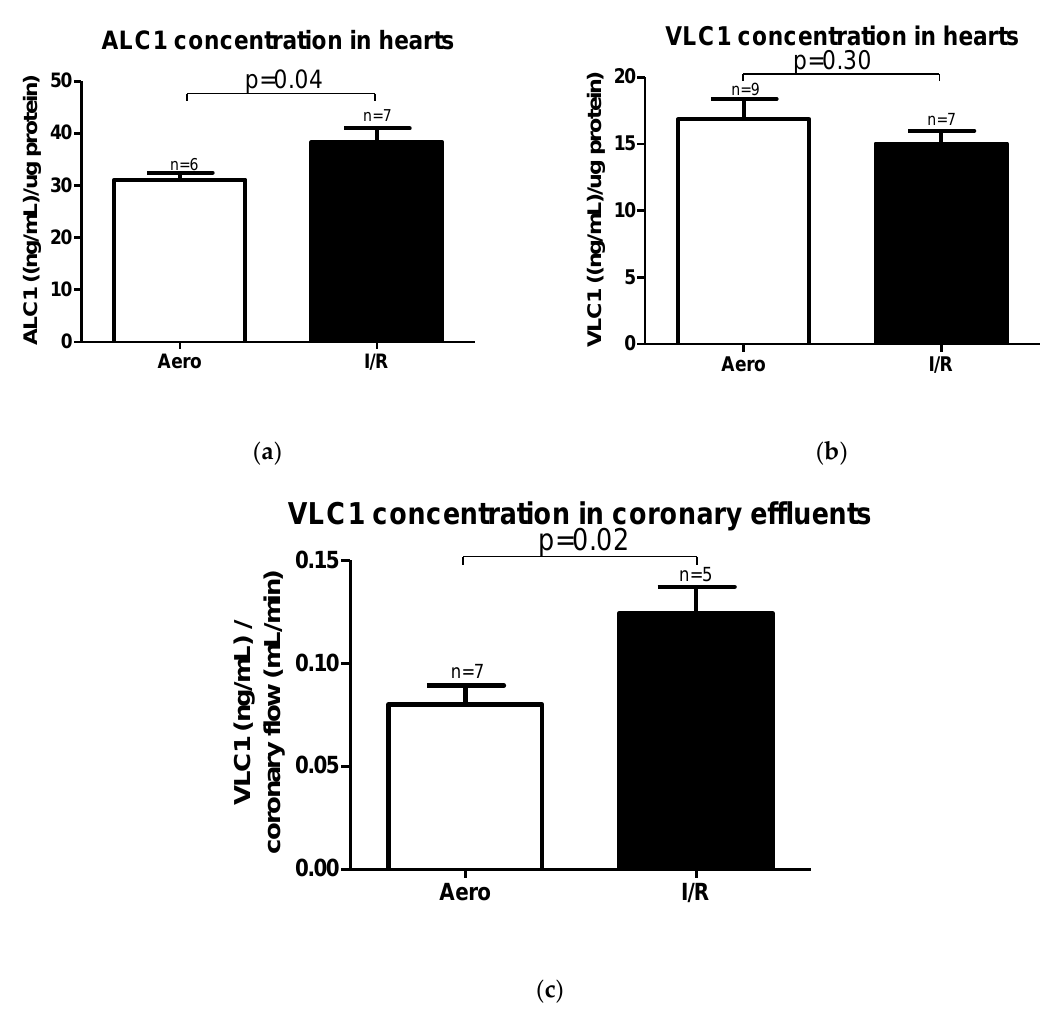
Figure 7. ( a ) Atrial light chain 1 (ALC1) and ( b ) ventricular light chain 1 (VLC1) concentrations in heart homogenates measured using ELISA tests and normalized to the content of protein in each sample; ( c ) VLC1 concentration in coronary effluents normalized to coronary flow; all data are expressed as mean ± SEM.